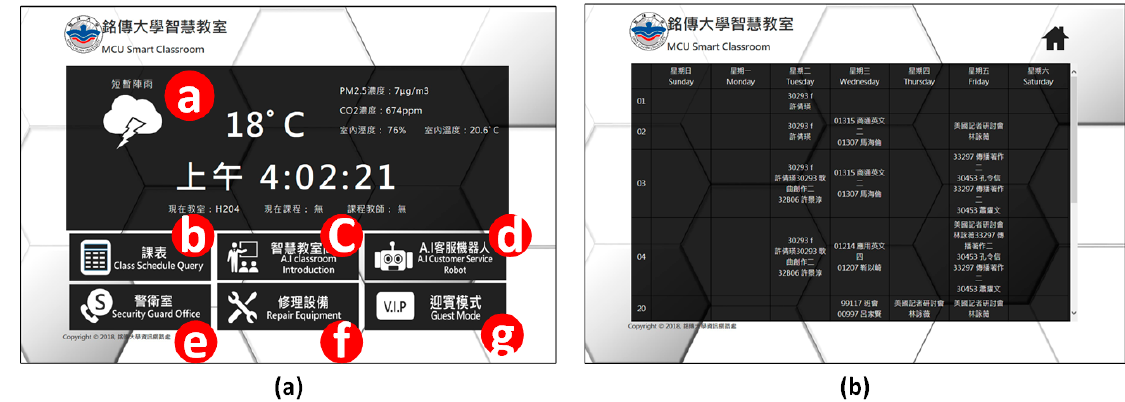
Figure 7. Information board can provide rich classroom context information and interactive functions: In part ( a ) of this figure, the board shows information including time, weather, class, CO 2 level, PM 2.5 level, indoor temperature, and humidity in portion a. Users can get dynamic classroom schedule, which is shown in part ( b ), by pressing button b. The functions of button c, d, e, f, g are ‘Smart